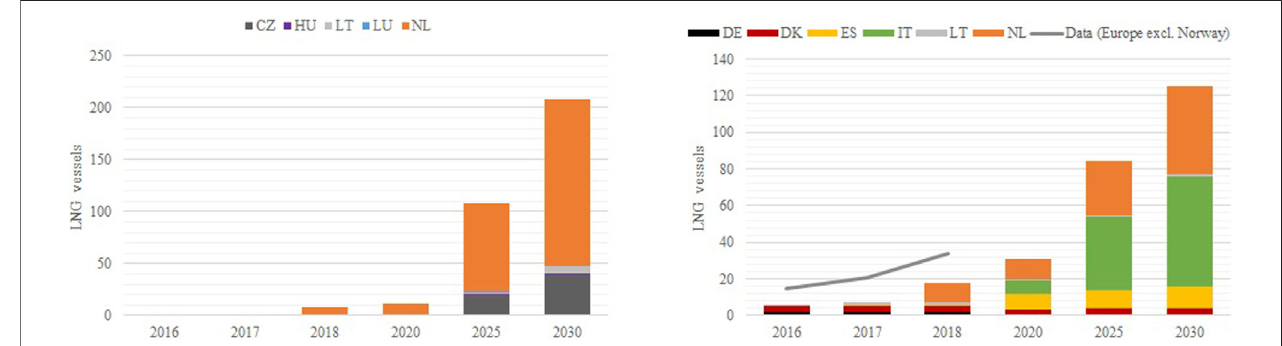
FIGURE7 | LNG vessels: inland (left) and maritime (right). Source: adapted from EC (2022), based on NIR and NPFdata and estimates as well ason databy DNV- GL (2021) reported by EAFO